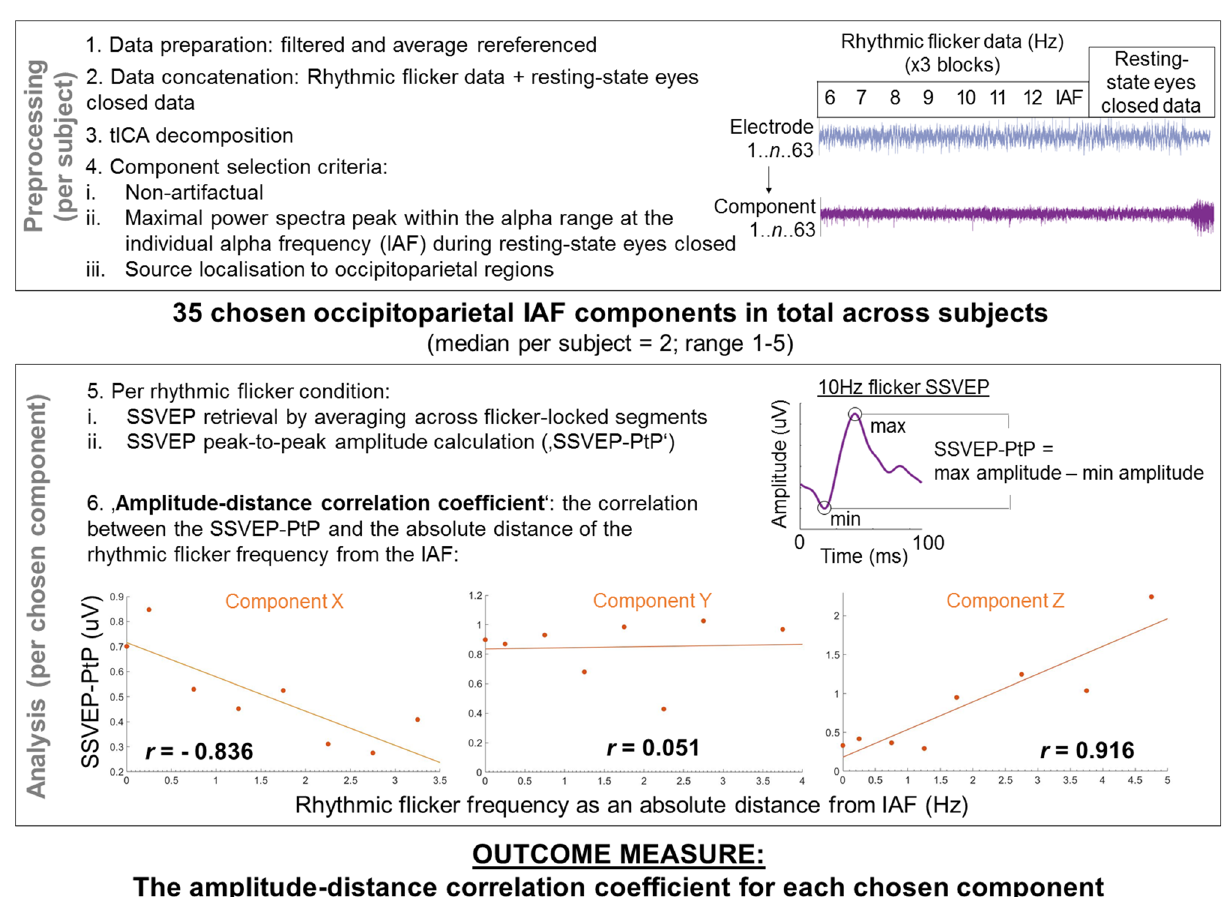
Figure 2. Analysis pipeline. Filtered and average re-referenced continuous data were epoched into rhythmic flicker 20 s stimulation trials and combined across blocks along with the 60 s resting-state eyes closed data and entered into a temporal ICA to derive 63 independent components across rhythmic stimulation trials and resting-state eyes closed per subject ( n = 14). For each subject, independent components with a maximal peak in the alpha range at the individual alpha frequency (IAF), above 1/f aperiodic signal, during resting state eyes closed and source localised to occipitoparietal regions were chosen for further analysis as our alpha oscillators, resulting in 35 distinct alpha oscillatory components across all subjects (range 1–5 alpha components per subject, median per subject = 2). For each of these 35 chosen components, the peak-to-peak amplitude of the SSVEP (‘SSVEP-PtP’) per rhythmic flicker frequency condition was retrieved and correlated with the absolute distance of the rhythmic flicker frequency from IAF, giving one amplitude-distance correlation coefficient of the relationship between the SSVEP-PtP and the absolute distance of the rhythmic flicker frequency from IAF per chosen component as our outcome measure. Three different patterns based on real data are shown (example components X, Y, Z), representing the hypothesised variability in the SSVEP-PtP across occipitoparietal alpha oscillators as an absolute distance of rhythmic flicker frequency from were also calculated in a supplementary analysis looking at the fundamental and second harmonic evoked ampli- tude to flicker across chosen components, expressed as z-scores (see Supplementary Analysis S4 and Figure S8). Outcome measure amplitude‑distance correlation coefficient. Each of the eight rhythmic flicker frequencies were transformed to reflect how far away the stimulation frequency was from the IAF in absolute terms ( flicker‑IAF distance ), e.g., given an IAF of 9.25 Hz, the 6 Hz condition would be 3.25 Hz as an absolute distance from the IAF, and the 11 Hz condition would be 1.75 Hz. The Pearson’s correlation coefficient between the SSVEP-PtP and the flicker-IAF distance was taken as our outcome measure, the amplitude‑distance correlation coefficient , for each of our 35 chosen occipitoparietal alpha oscillators. This value describes the pattern of how SSVEP amplitudes to rhythmic flicker stimulation vary as a function of flicker-IAF distance. A positive correlation coefficient would indicate a minimal SSVEP-PtP at the IAF, increasing as a function of flicker-IAF distance. A negative correlation coefficient would indicate a maximal SSVEP-PtP at the IAF that decreases as a function of flicker-IAF distance. A near-zero correlation coefficient would indicate no change in the SSVEP-PtP as a function of flicker-IAF dis- tance. Note that an amplitude inversely proportional to frequency regardless of IAF (i.e., simply following the 1/f decay) would result in increasing SSVEP-PtP for rhythmic flicker frequencies less than the IAF and a decreasing SSVEP-PtP for rhythmic flicker frequencies greater than the IAF and would also result in a near-zero correlation.